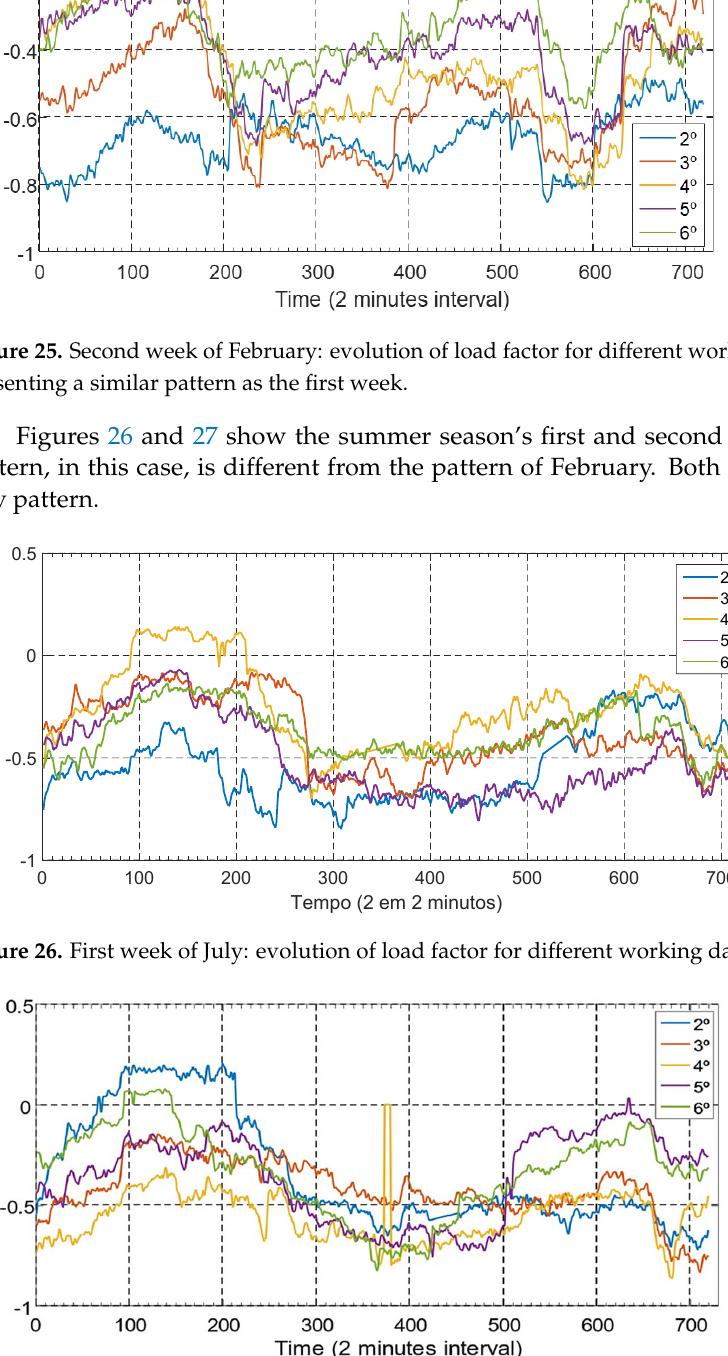
Figure 27. Second week of July: evolution of load factor for different working days (2nd to 6th), presenting a similar pattern as the first